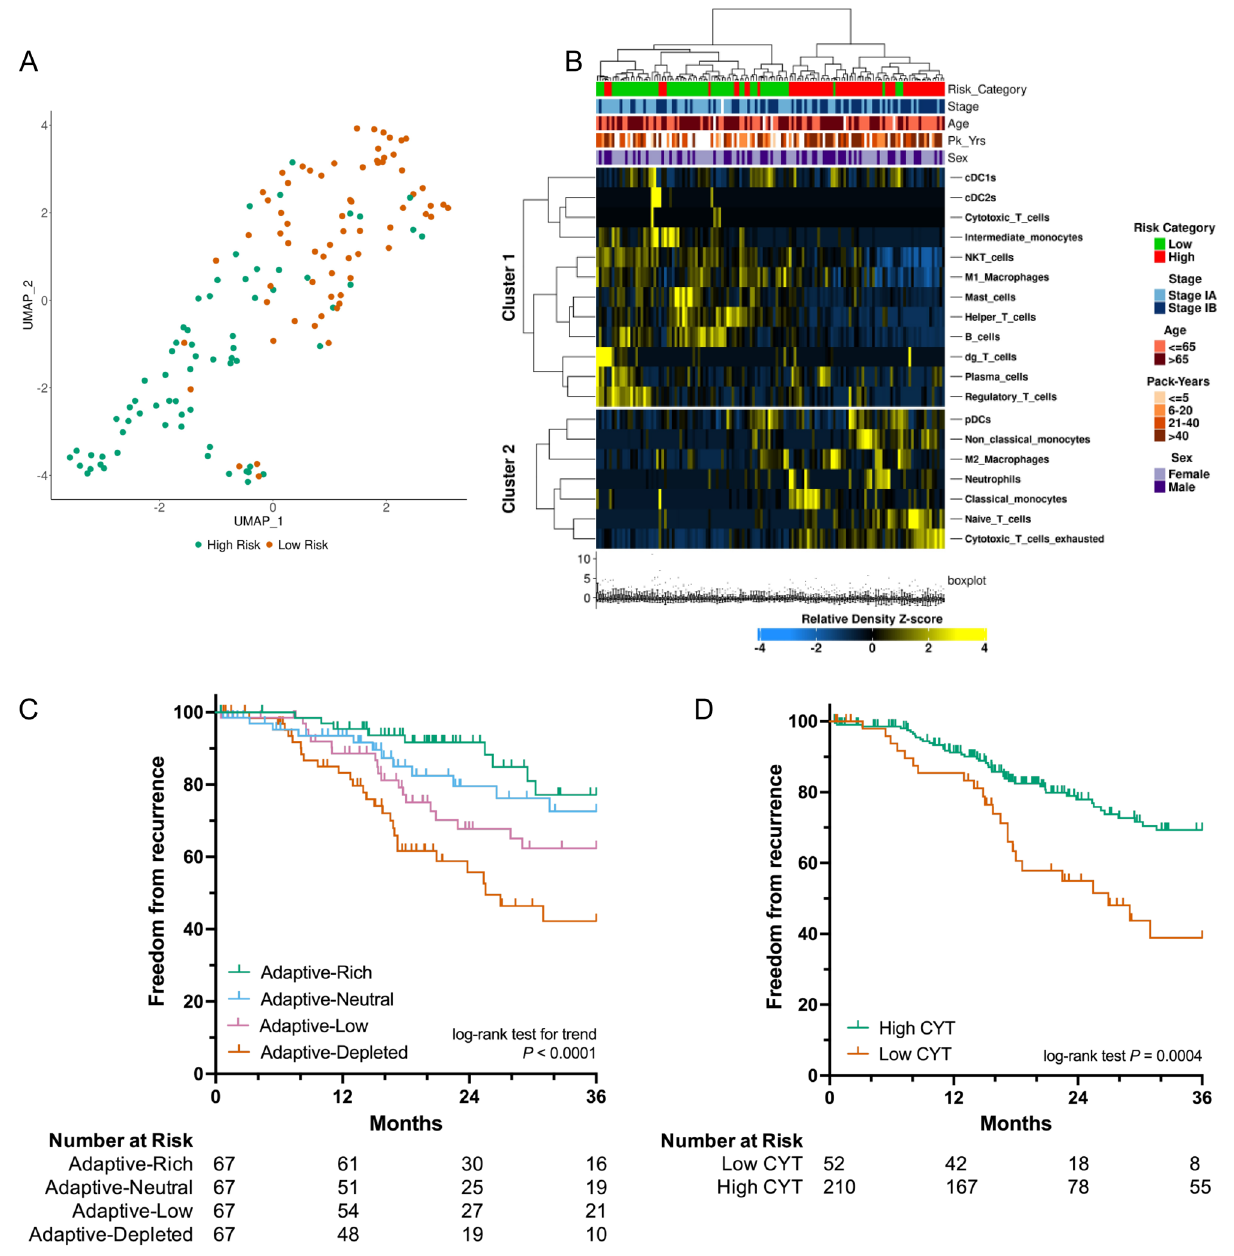
Figure 6. Recurrent stage I lung adenocarcinomas display adaptive immune cell depleted phenotypes. UMAP analysis reveals distinct tumor immune microenvironments between recurrence high- and low-risk tumors ( A ). Heatmap analysis demonstrates depletion of adaptive immune cell populations in recurrence high-risk tumors ( B ). Patients with adaptive-rich immune cell phenotypes have improved 24-month freedom from recurrence compared to tumors with adaptive-depleted phenotypes ( C ). High cytolytic activity score (CYT) is prognostic of decreased recurrence ( D ). *** P < 0.0001, ** P < 0.001, * P <